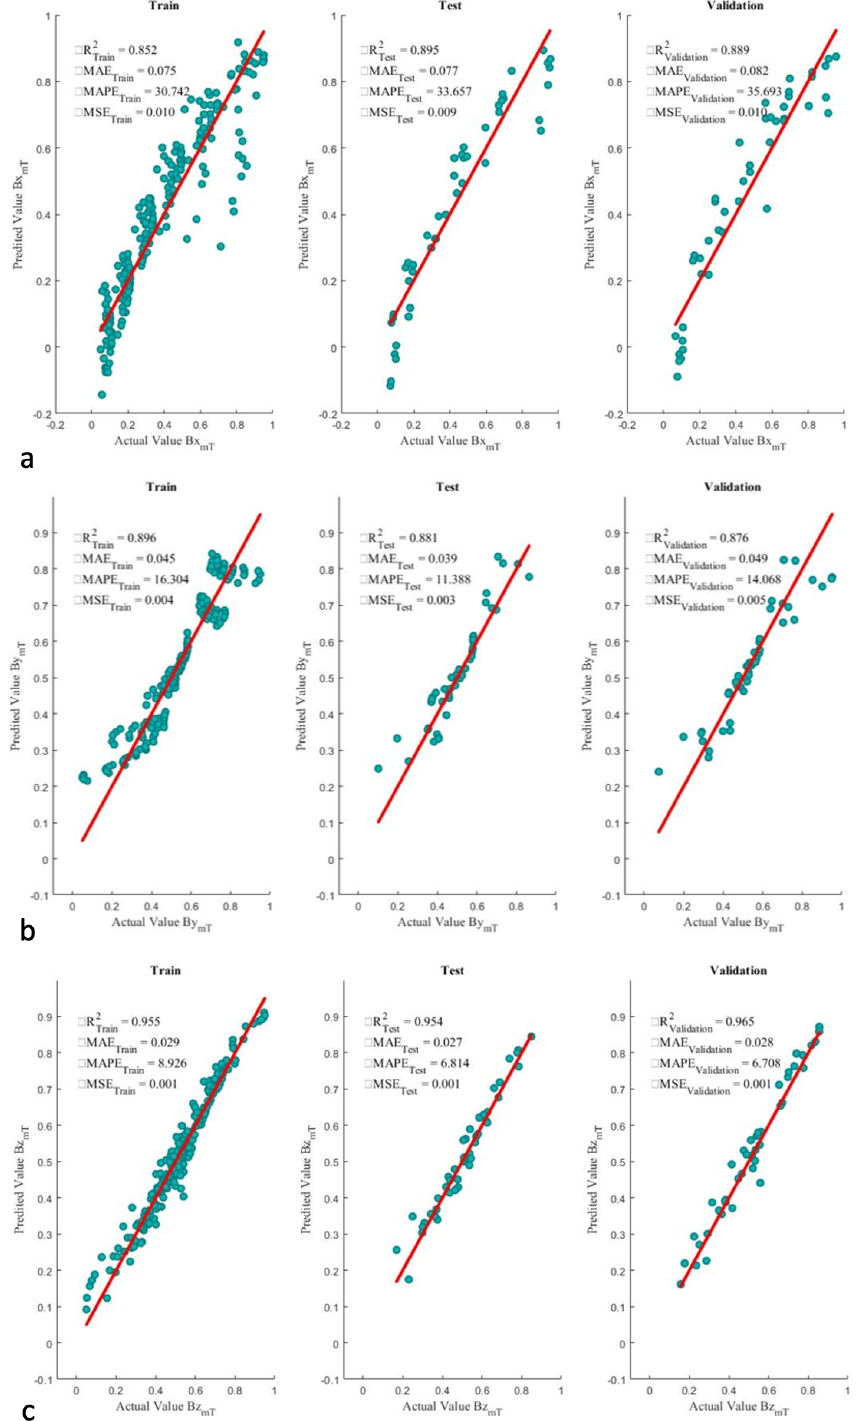
Figure 14. Scatter plot of optimized ANN algorithms for ( a ) B x , ( b ) B y , and ( c ) B z